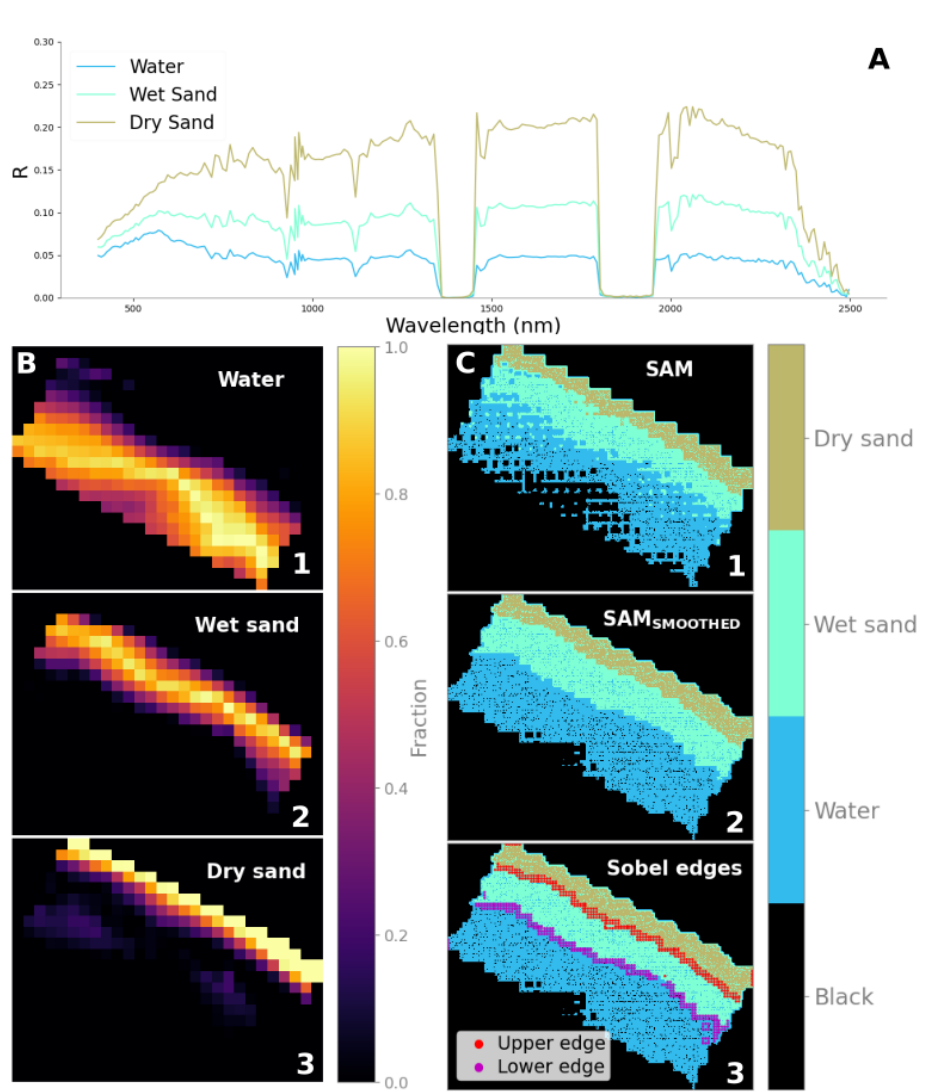
Figure 3. Example of the procedure applied to obtain the SDS with method II: k-means approach. Panel ( A ) shows the spectral signatures corresponding to the centroids obtained with k-means, indicating the number of final clusters as three: water, wet sand and dry sand. Panel ( B ) shows the abundance maps resulting from applying FCLS with the spectral signatures shown in A. Finally, panel ( C ) shows: in 1 , the class map applying the SAM method to the abundance maps; in 2 , the class map after modifying the classes of the isolated pixels and in 3 , the edges of the wet sand class obtained by applying Sobel (in red the upper edge and in purple the lower